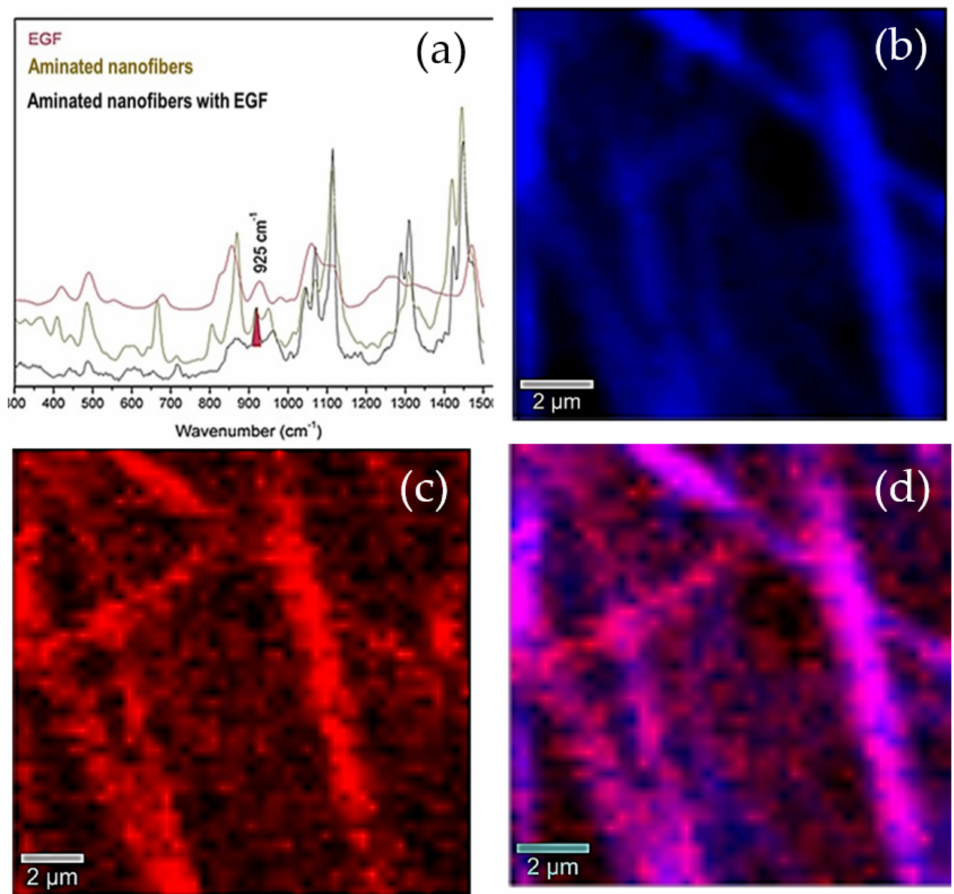
Figure 3. Raman spectra and label free 2D images of aminated nanofibers with EGF. ( a ) selected Raman spectra bands ( b ) The blue image is generated by the integration of signal at ~2857 cm − 1 at- tributed to the C-H stretching vibrations in polycaprolactone (PCL). ( c ) The image in red is calculated by the integration for a center of mass of the peak at ~925 cm − 1 attributed to the EGF. ( d ) The image in purple represents the distribution of EGF in the aminated nanofibers with